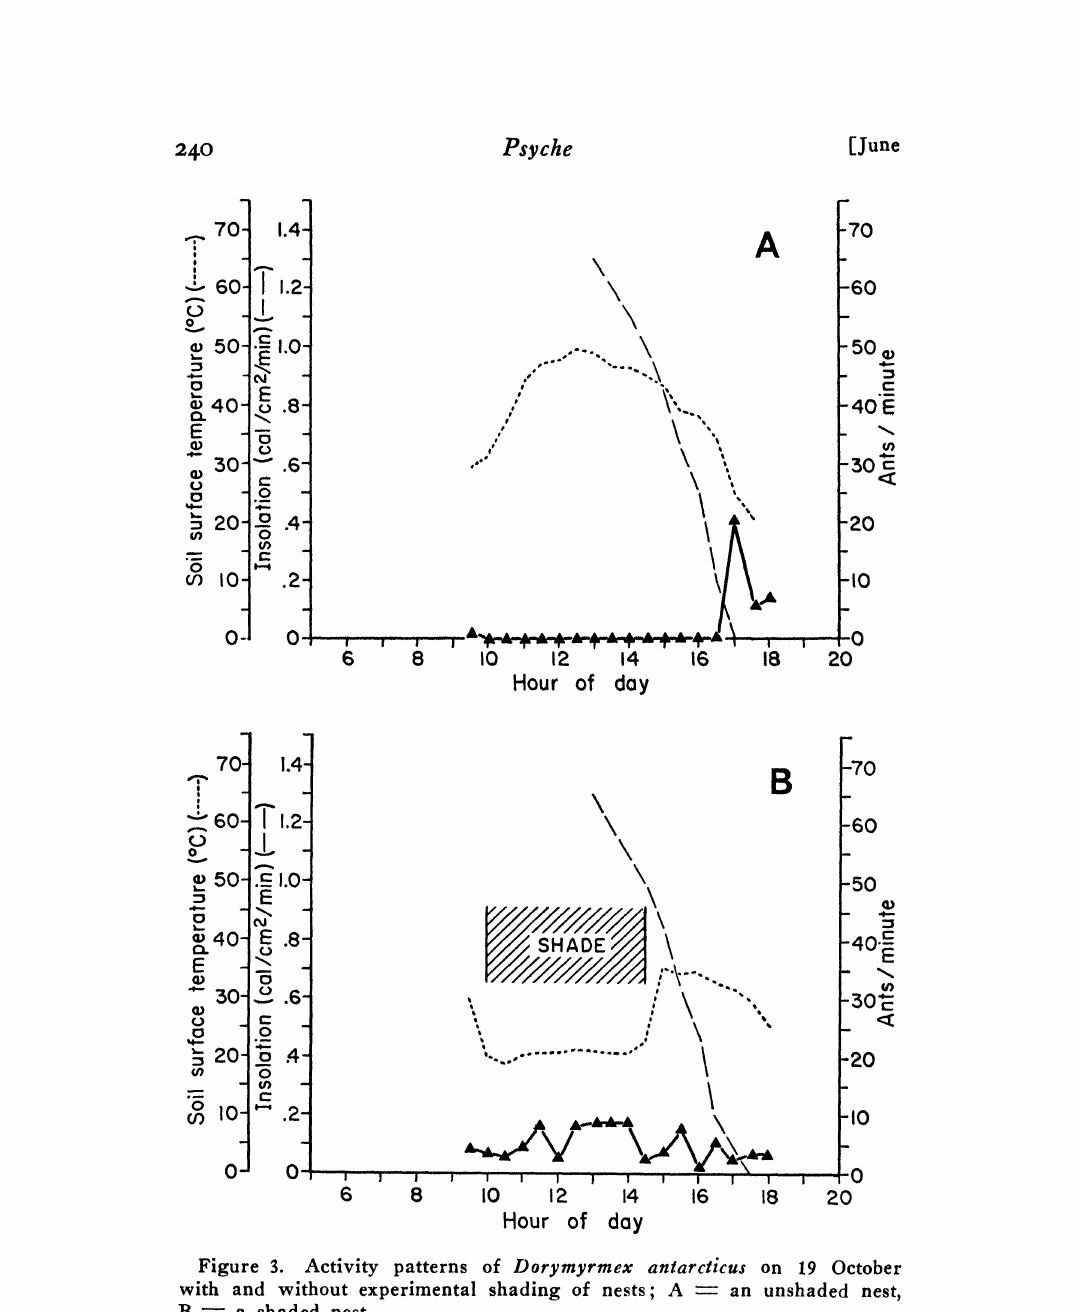
Figure 3. Activity patterns of Dorymyrmex antarcticus on 19 October with and without experimental shading of nests; A an unshaded nest, B- a shaded